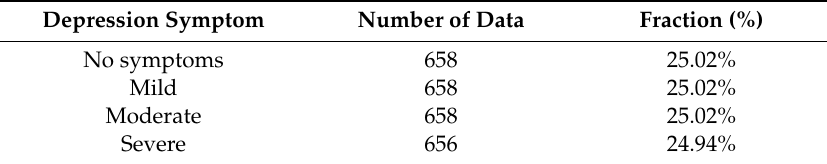
Table 8. The number of samples after using hybrid